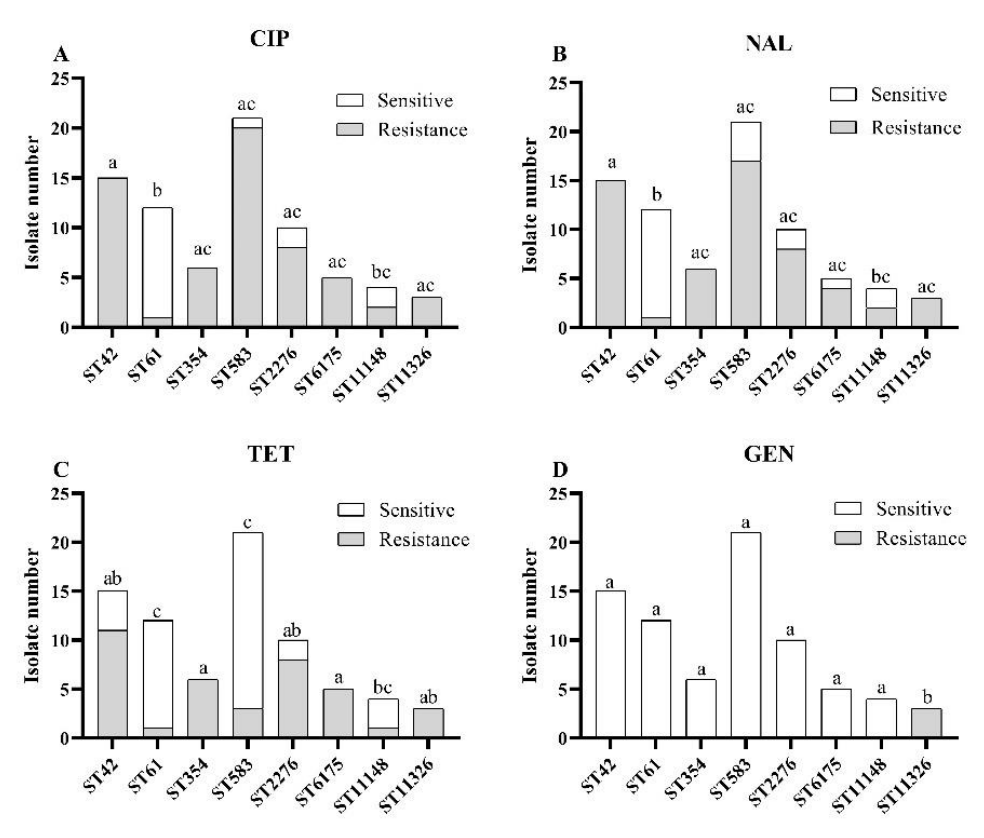
Figure 1. Correlations between STs and resistance to four antibiotics. ( A ) CIP; ( B ) NAL; ( C ) TET; ( D ) GEN. The same letter on column represents no significant difference ( p ≥ 0.05); a different letter represents a significant difference between STs ( p < 0.05).